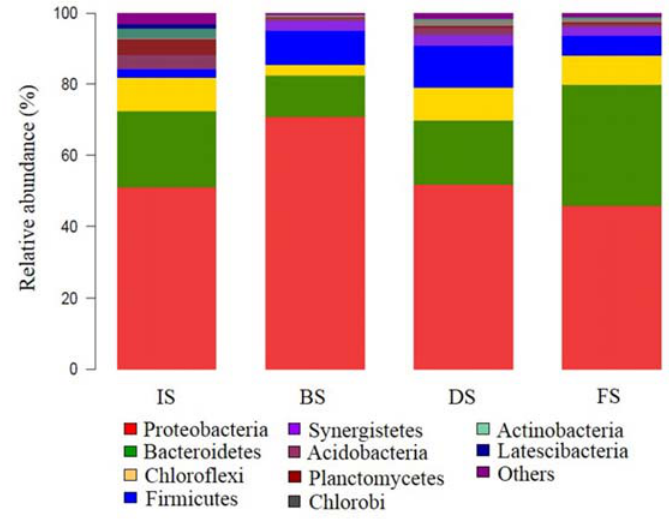
Figure 7. Microbial community structure and composition by phylum in samples from the MLCOP reactor.